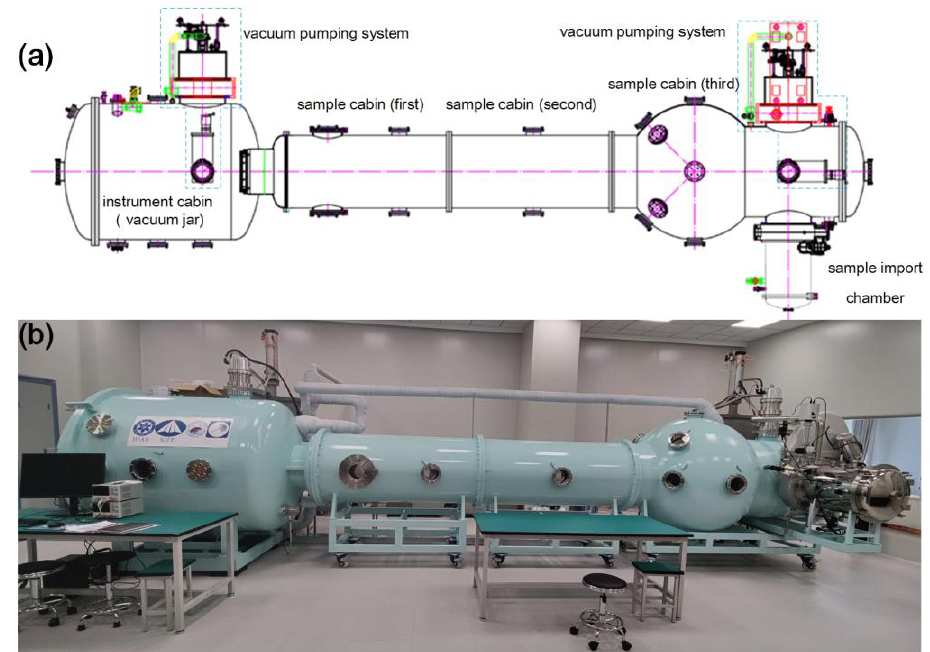
Figure 2. Schematic diagram ( a ) and photograph ( b ) of the facility for Martian atmospheric environ- ment simulation, which is located in Hangzhou,